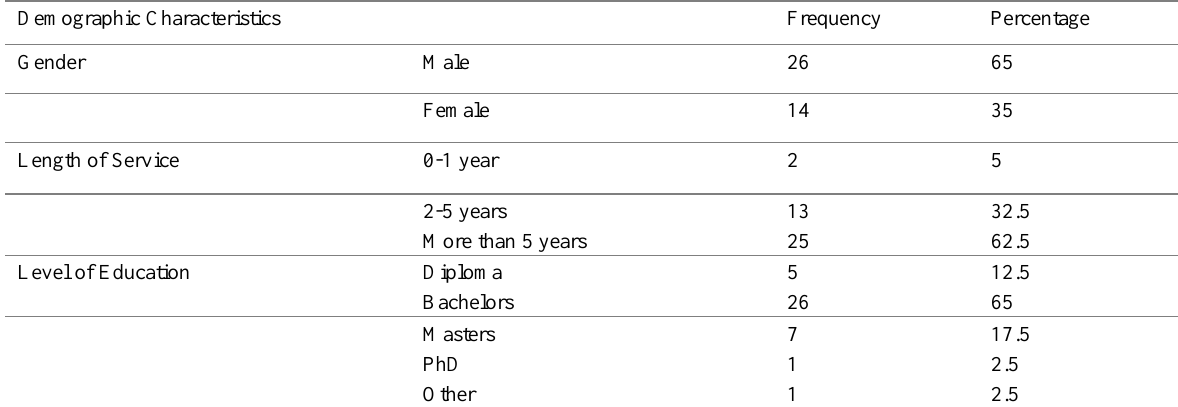
Table 1 : Demographic